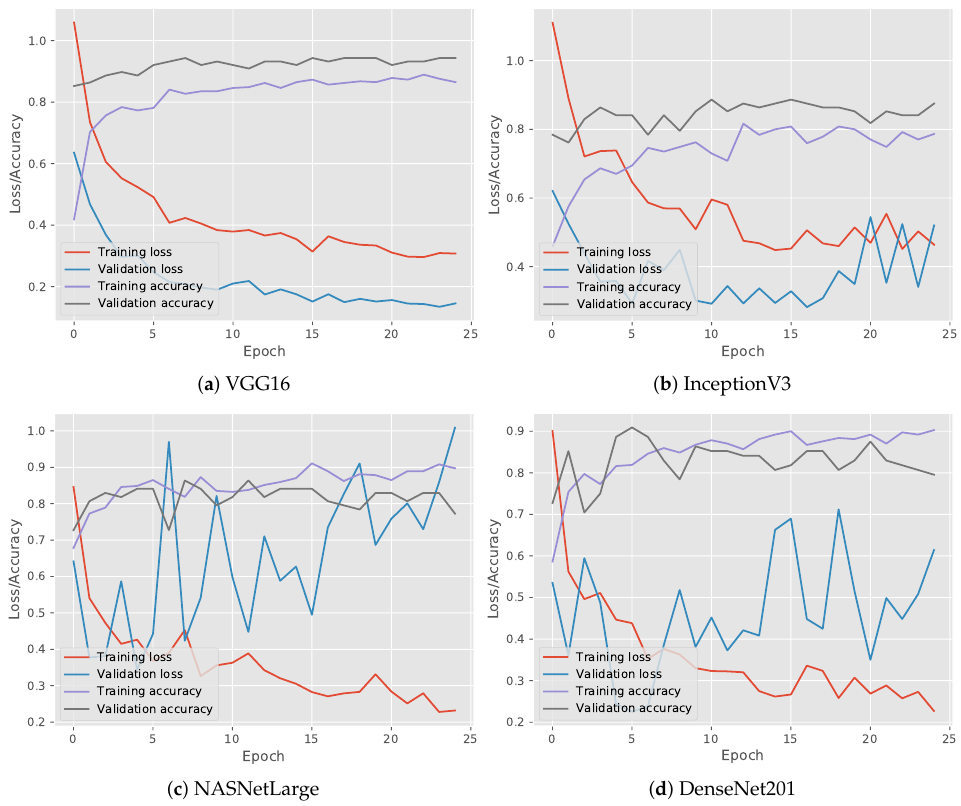
Figure 16. Accuracy and loss (train and test) of deep learning models for Pattern